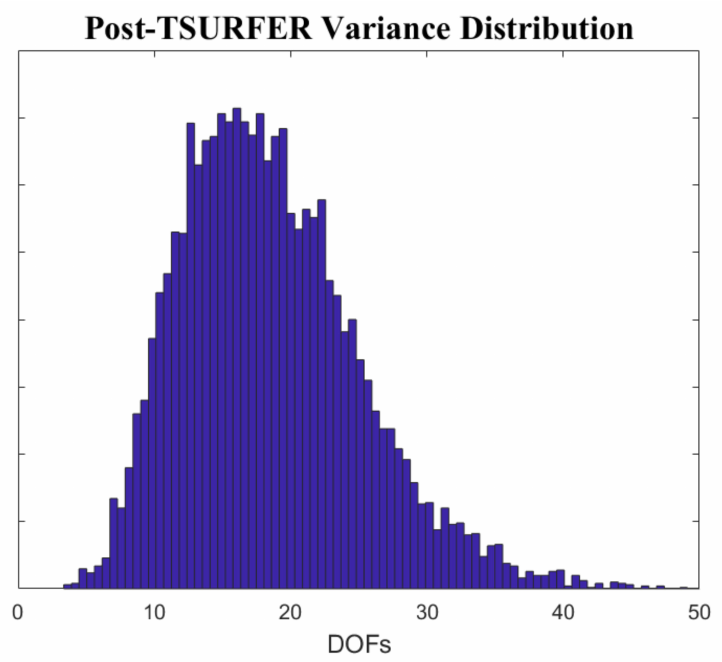
Figure 7. DOFs of the variance of experiments'